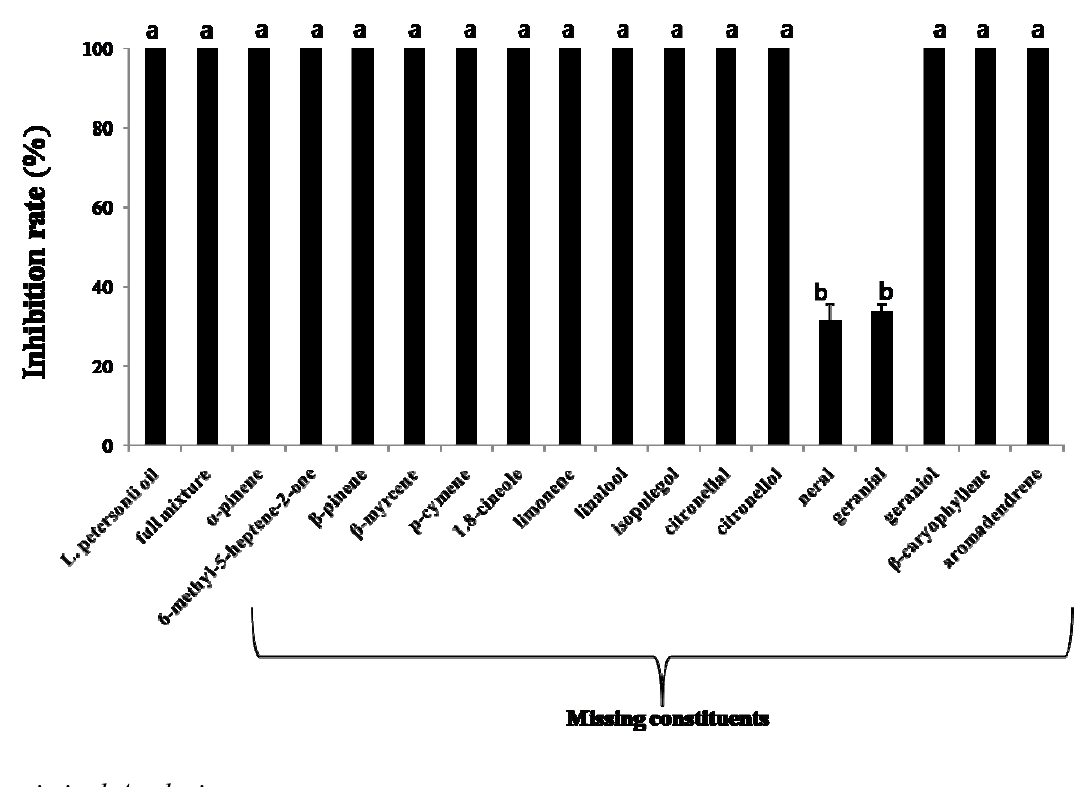
Figure 1. Fumigant antifungal activity of the oil, full mixture, and selected blends of the constituents of L. petersonii essential oil against Aspergillus flavus . The air concentration of L. peterisonii was 28 × 10 − 3 mg/mL. The air concentration of the full mixture of L. peterisonii oil was 25.43 × 10 − 3 mg/mL. The concentrations of other blends were determined by removing each constituent equivalent to the ratio identified in L. peterisonii oil. Mean values corresponding to each treatment with different letters are significantly different from each other (F = 1.158, p < 0.0001, Scheffe’s 16,51